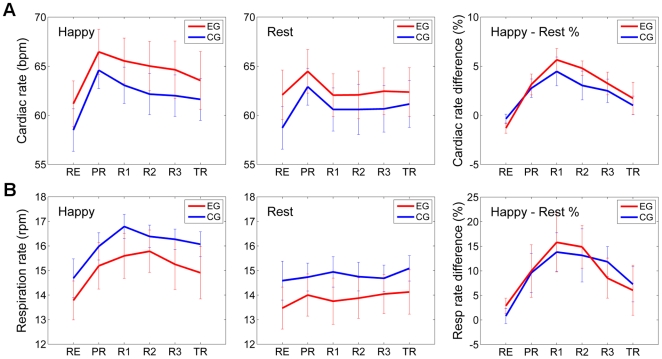
Cardiac and Respiratory Rate Variations during the Neurofeedback Experiment.
A) Average Cardiac Rate. The experimental group (EG, red) and control (sham) group (CG, blue) exhibited no statistically significant differences in mean cardiac rates for either Happy Memories or Rest conditions for any of the six experimental runs. B) Average Respiratory Rate. Similarly, no statistically significant differences were observed in mean respiratory rates of the two groups (EG and CG) for either condition for any of the runs.